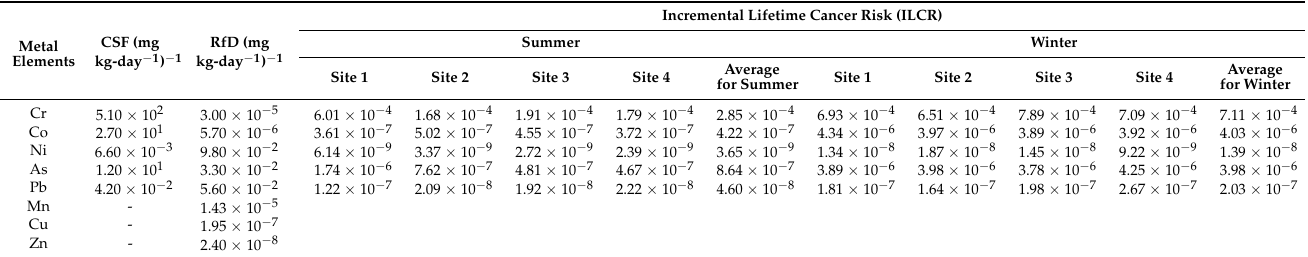
Table 3. Incremental lifetime cancer risk (ILCR) and reference doses for chronic (70-year average) daily intake.